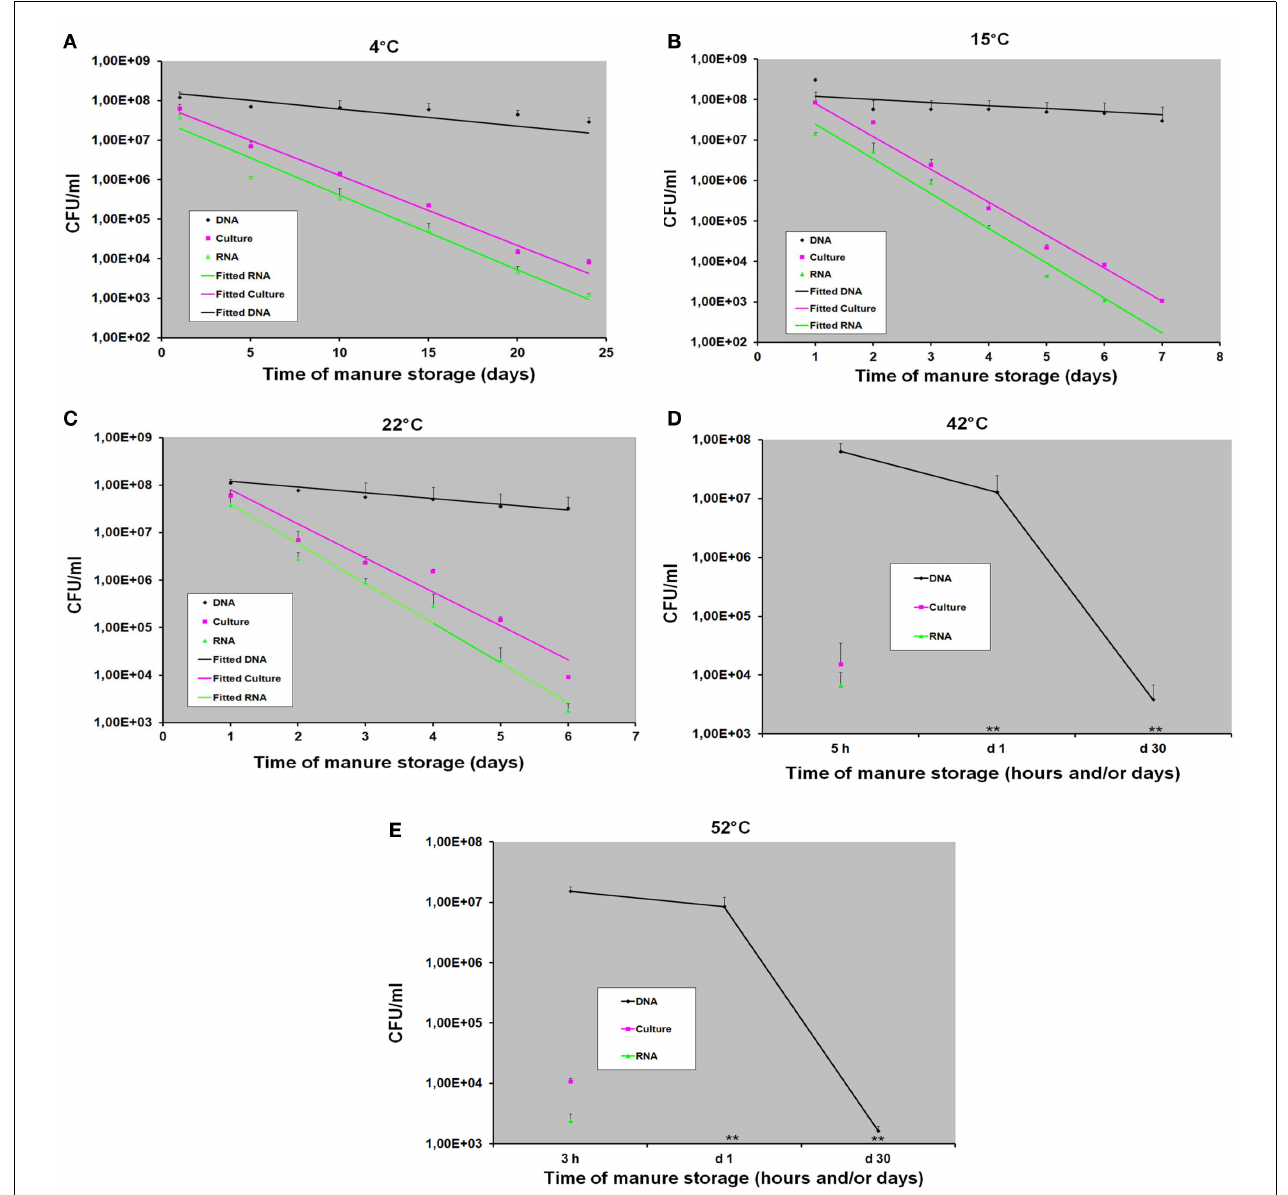
methods with (A) at 4˚C, (B) at 15˚C, (C) at 22˚C, (D) at 42˚C, and (E) at 52˚C. Data are means and SE of at least three independent experiments; (**): not